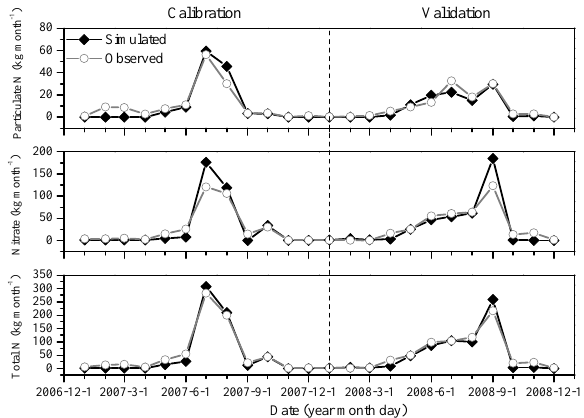
Fig. 3. Simulated and measured monthly particulate nitrogen load- ings (a) , nitrate loadings (b) and total nitrogen loadings (c) for the calibration (2007) and validation (2008) years.